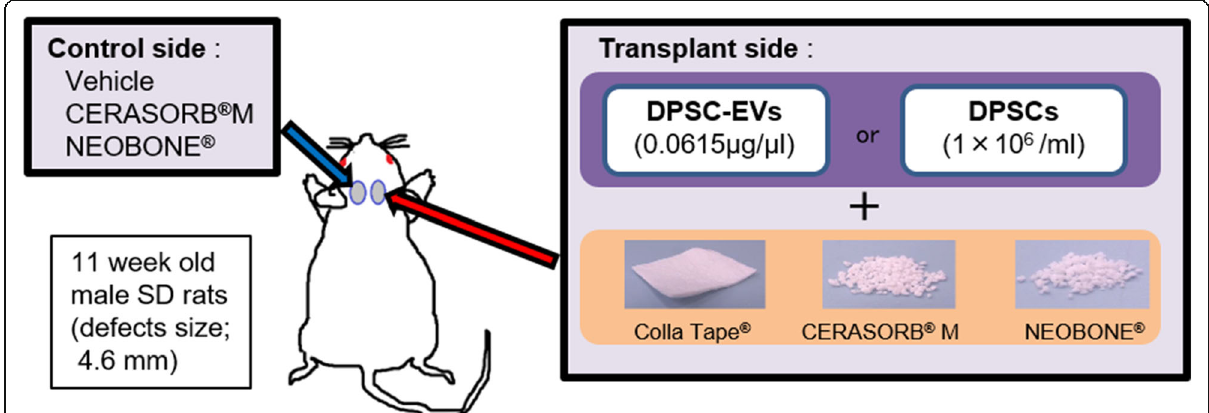
Fig 1. Experimental protocol. Defects with a diameter of 4.6 mm were created in the parietal bones of 11-week-old SD rats. DPSCs or DPSC-EVs and scaffold materials were transplanted into the defect on the right side. Vehicle was administered and scaffold materials were filled to the control defect on the left